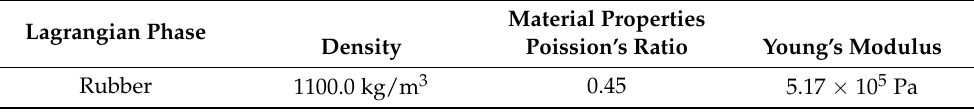
Table 2. Polydisperse rubber microparticles